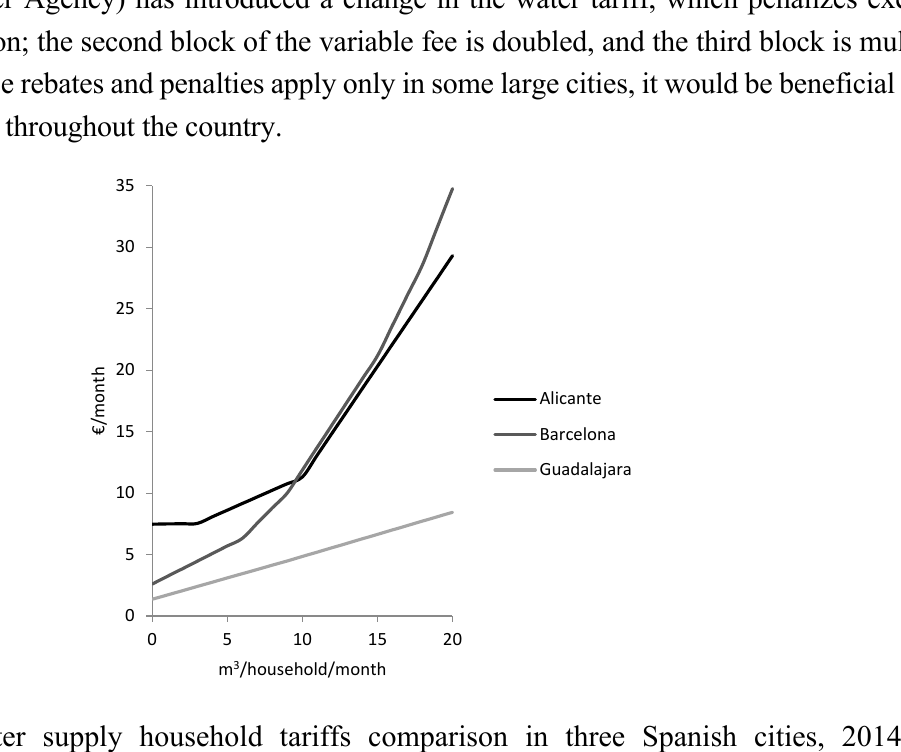
Figure 3. Water supply household tariffs comparison in three Spanish cities,